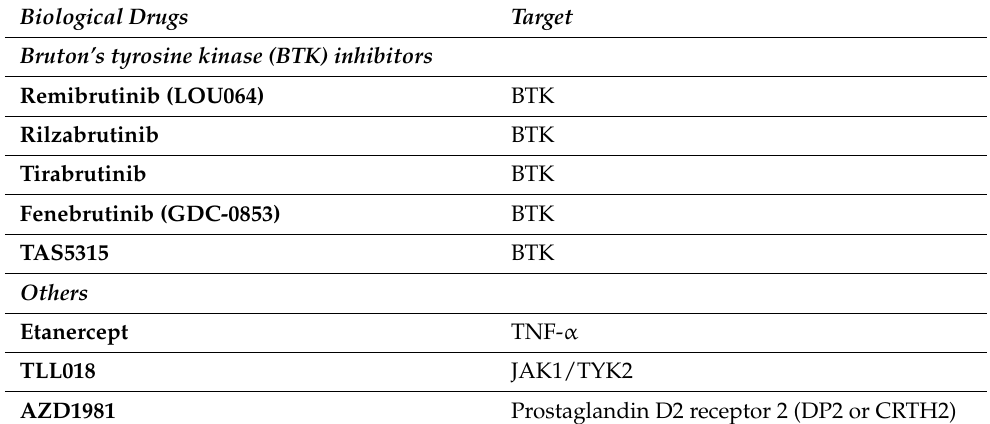
Table 6. Small molecules inhibitors and their target.